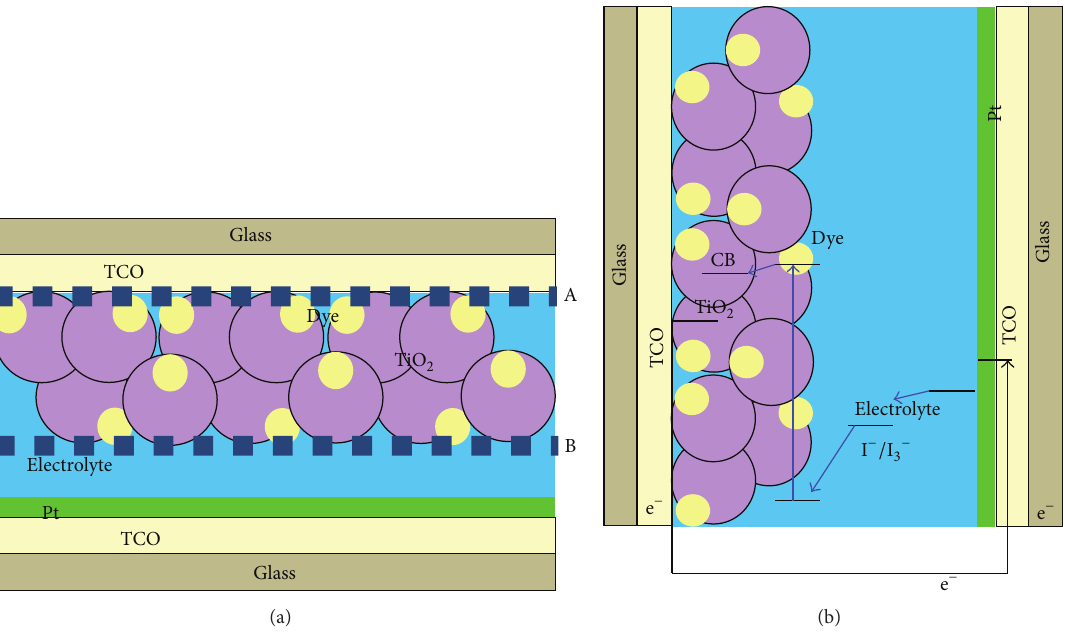
Figure 1: Illustration of DSC. (a) Structure. (b) Electron